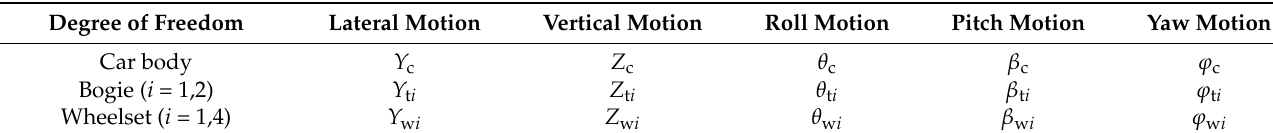
Table 1. Degree of freedom of vehicle model.